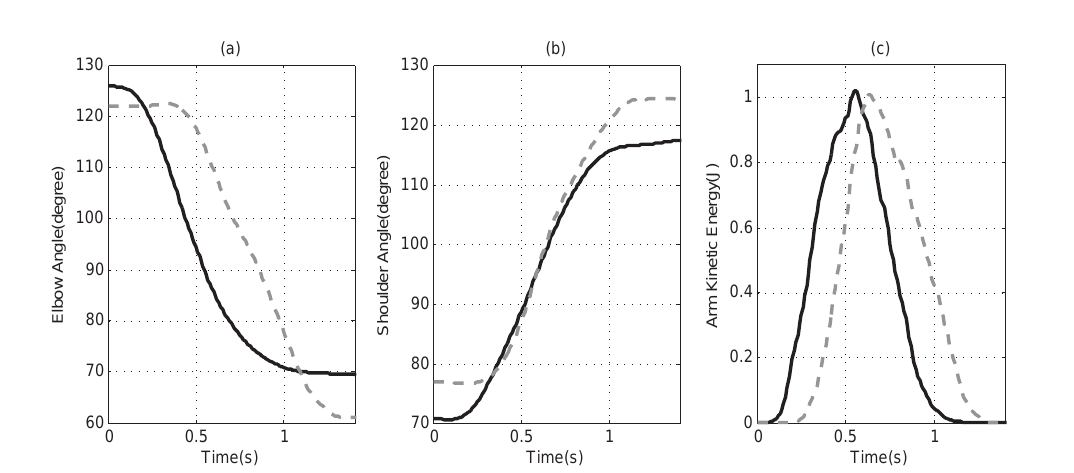
Figure 8: Measured elbow, shoulder joint angles and energy property profiles of two trajectories in Case C : (a) elbow joint angle plots, (b) shoulder joint angle plots, (b) arm kinetic energy profiles.